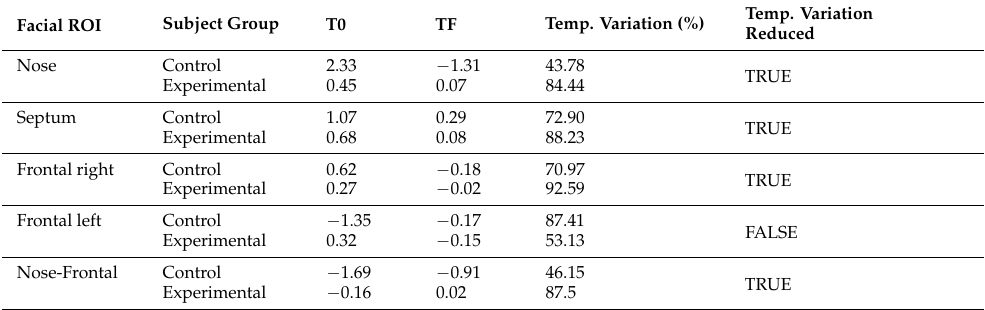
§ Nasal-frontal = the difference between: the mean between the two ROIs of the forehead and the nose tip. Table 6. Difference in facial ROI from T0 to TF in control and experimental groups, with a focus on the reduction in temperature variation between acclimatization and resting phase at TF with respect to